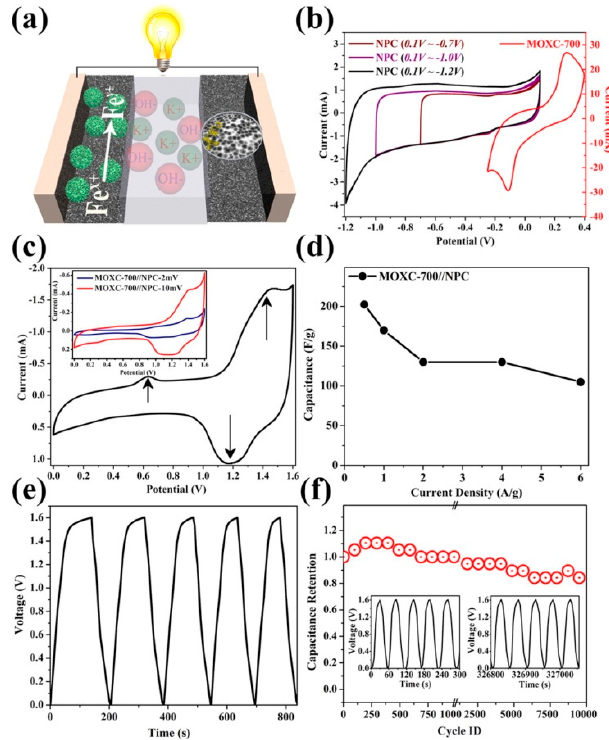
Figure 13. Schematic explanation of MOXC-700//NPC device in 6 M KOH electrolyte: ( a ) view of assembly, ( b ) comparative CV curves of positive and negative electrodes, ( c ) CV curves of the device, ( d ) capacitances of the device at different current loads, ( e ) charge − discharge curve of the device for the first five cycles, and ( f ) cycling performance for the device [184].